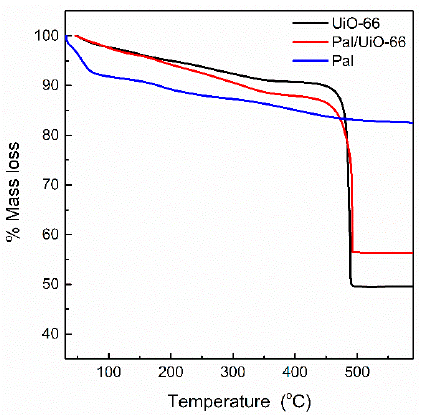
Figure 1. Thermogravimetric analysis (TGA) profiles of the pure UiO-66 and the composite containing palygorskite (Pal).